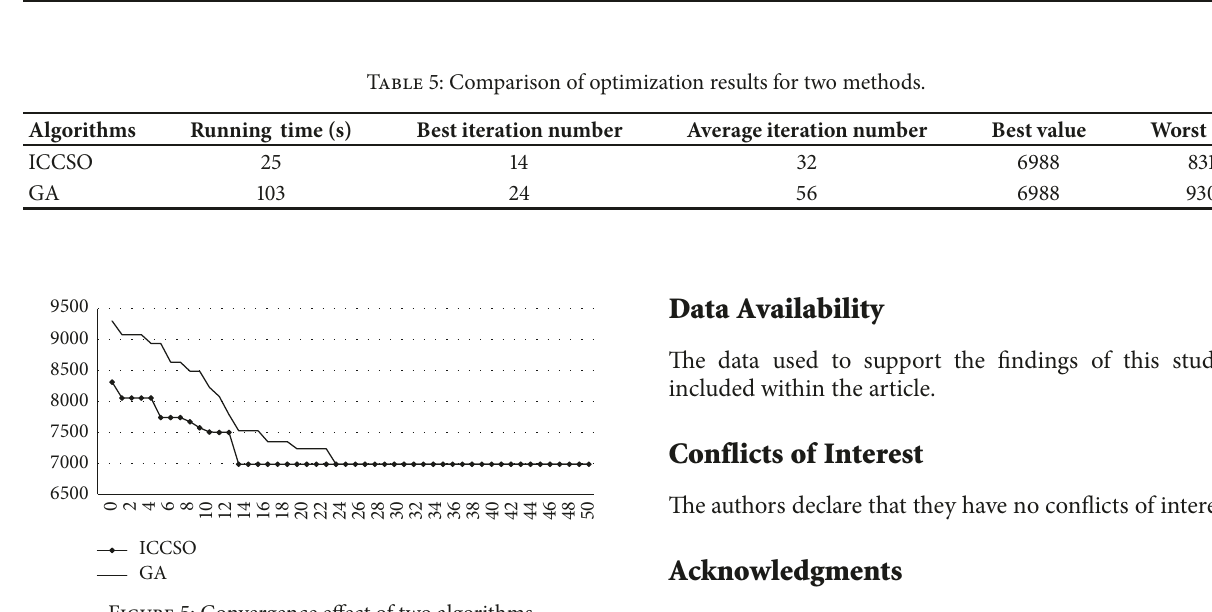
Figure 5: Convergence effect of two